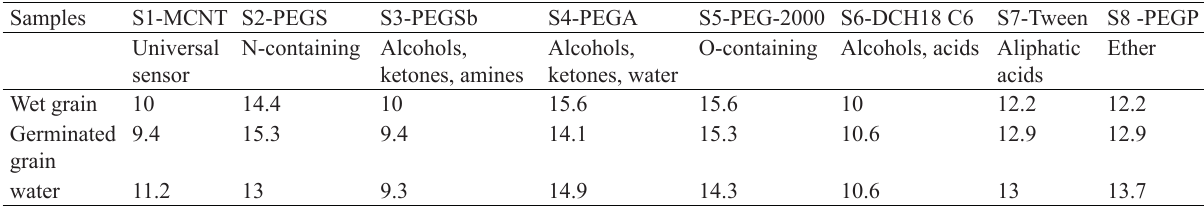
Table 4 Signal ratio of several sensors in the matrix for test samples Samples